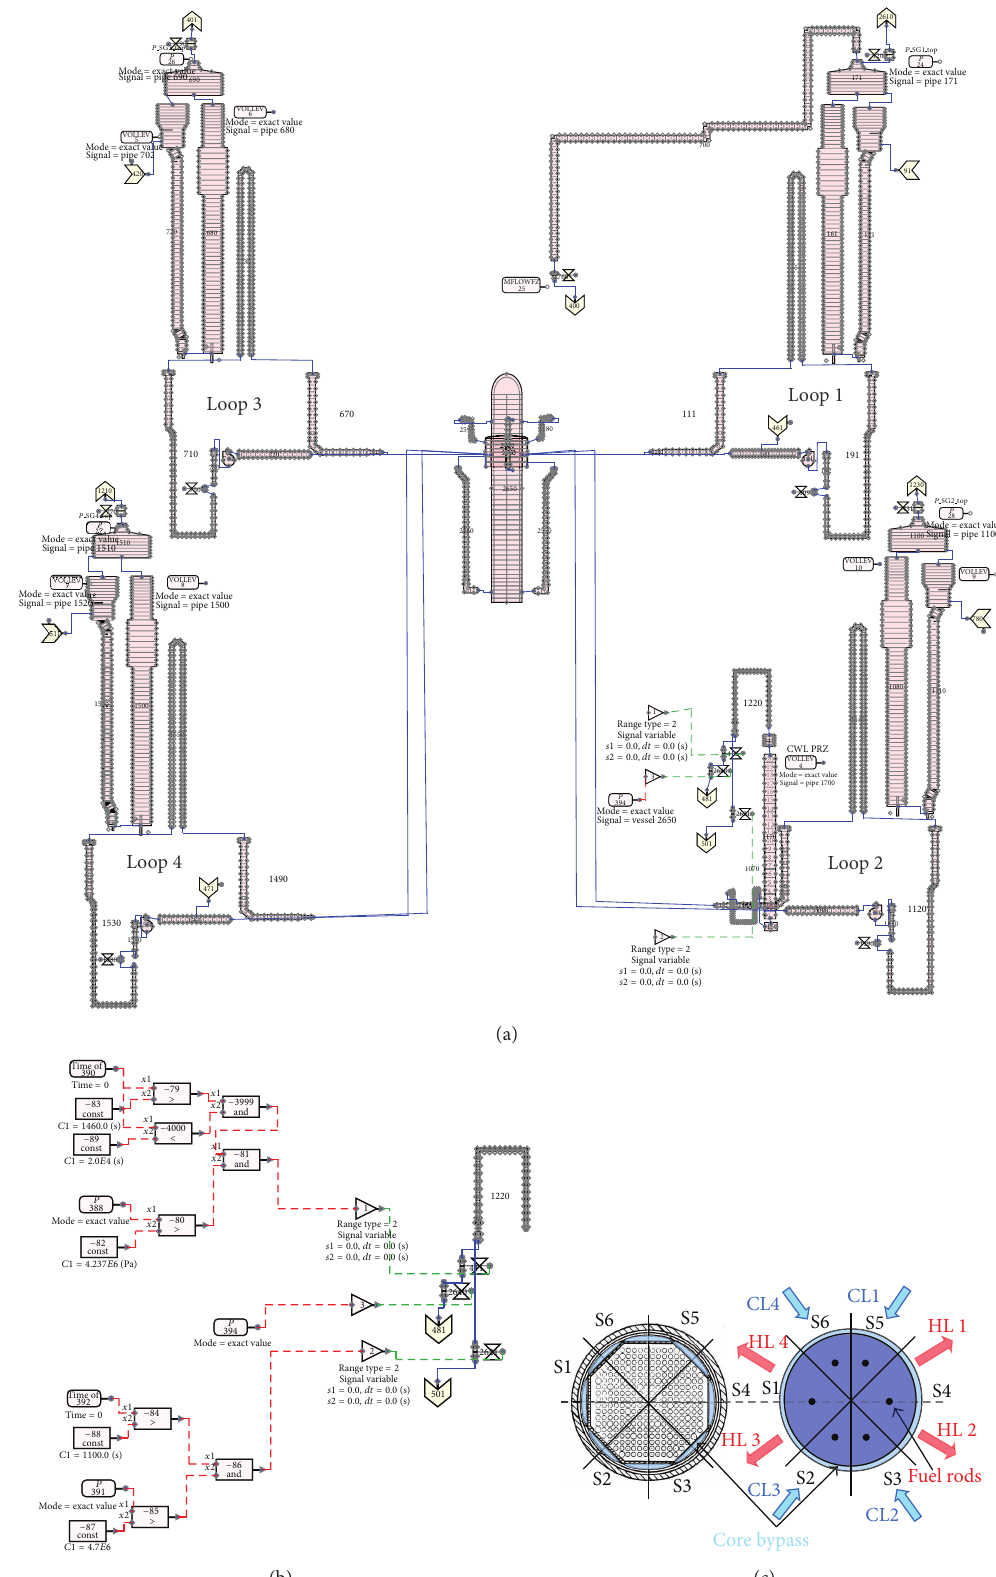
Figure 2: (a) TRACE nodalization of the PKL-2 integral test facility, (b) TRACE model of the relief valve and control systems, and (c) azimuthal and radial nodalizations of the core